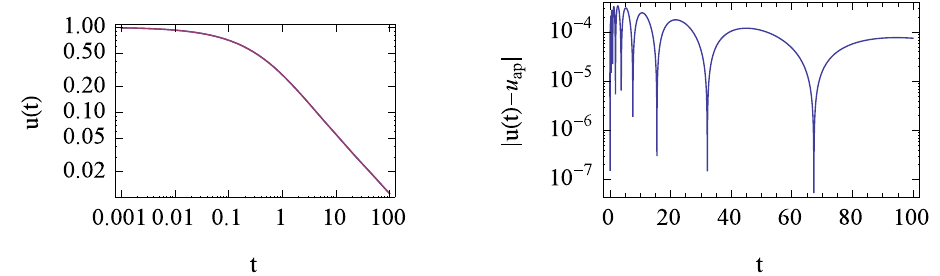
Figure 8. Solution of the fractional relaxation Equation (92) generated by the inverse Laplace transform of ~ G ( s ) .